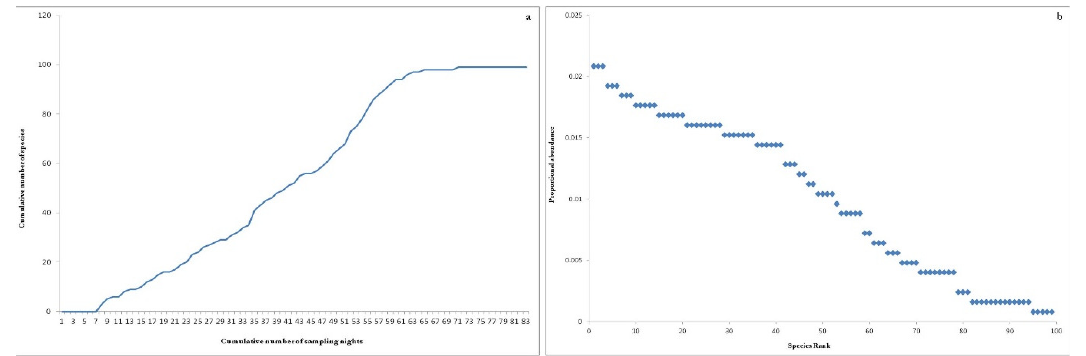
Figure 4. a. Species accumulation curve; x-axis = cumulative number of sampling nights, y-axis = cumulative number of species observed. b. Rank abundance curve displaying relative moth